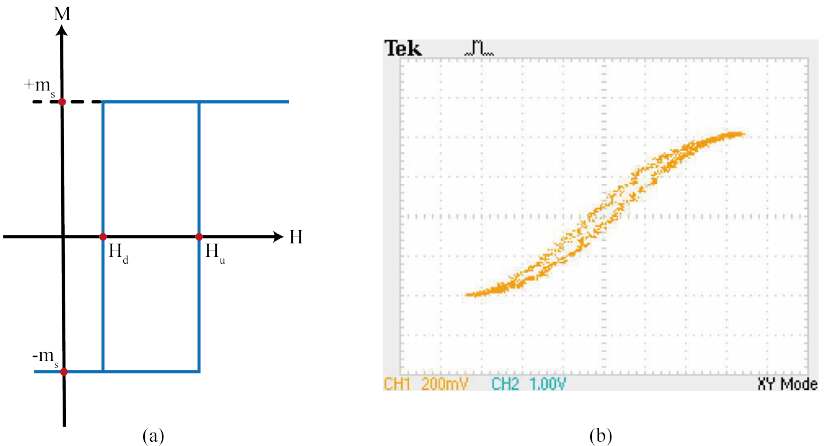
Figure 4. Hysteresis loop of ( a ) an oriented magnetic domain, ( b ) a multidomain particle of a 3C90 Epcos ferrite core at 500 Hz and 28.5 ◦ C. Source: Adapted from